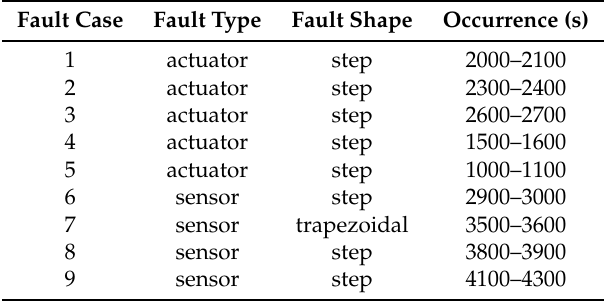
Table 4. Fault modes of the wind turbine